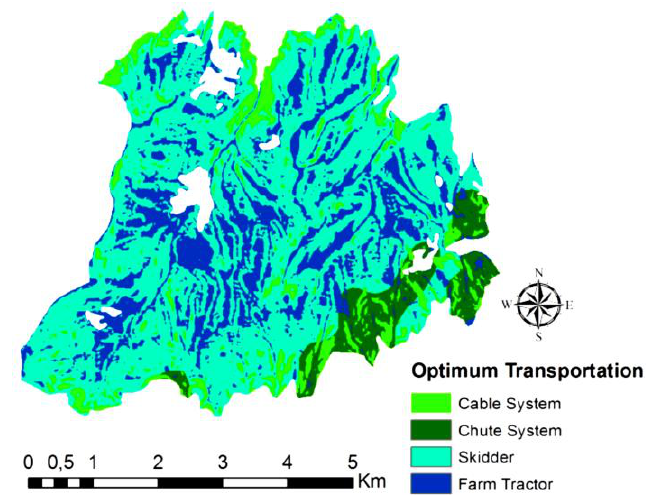
Figure 9. Skidder operation